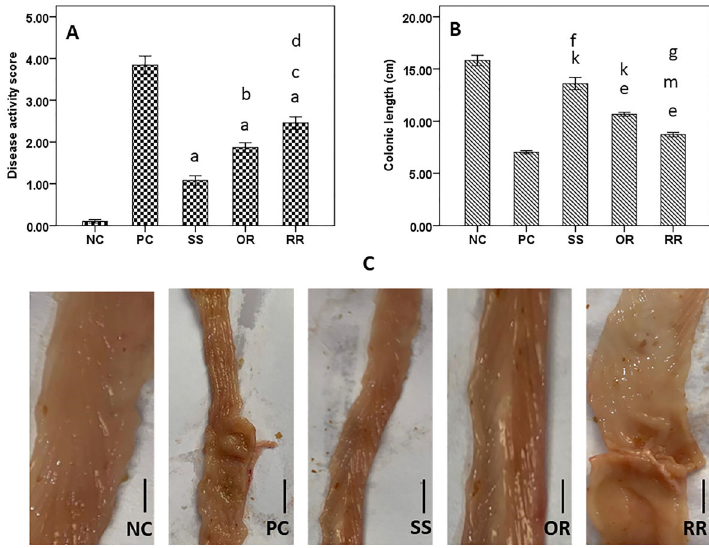
Figure 1. The effects of ro fl umilast in trinitrobenzenesulfonic acid (TNBS)-induced colitis in rats. A , Disease activity score: a P o 0.001 SS & OR & RR vs NC and PC, b P o 0.01 OR vs SS (P=0.003), c P o 0.001 RR vs SS, d P o 0.05 RR vs OR (P=0.037). B , Colon length: e P o 0.001 OR & RR vs NC, f P o 0.01 SS vs NC (=0.001), g P o 0.05 RR vs PC (=0.023), k P o 0.001 SS & OR vs PC, m P o 0.01 RR vs OR (=0.006). C , Colonic macroscopic appearance. The scale bar indicates 1 cm: The NC group shows a normal appearance of the